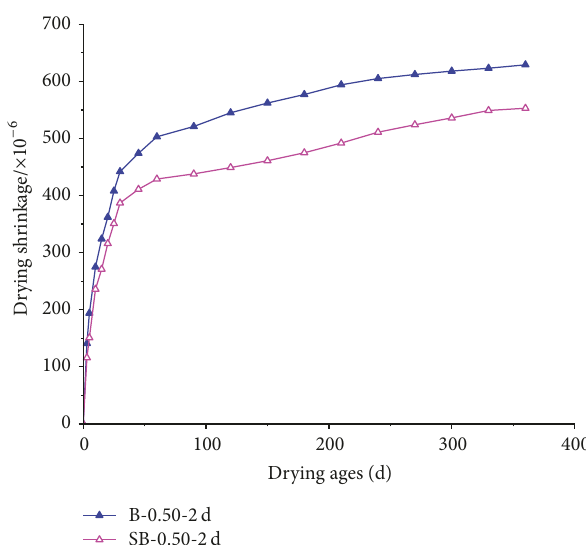
Figure 11: Drying shrinkage of GGBS concrete and SGGBS-GGBS concrete.